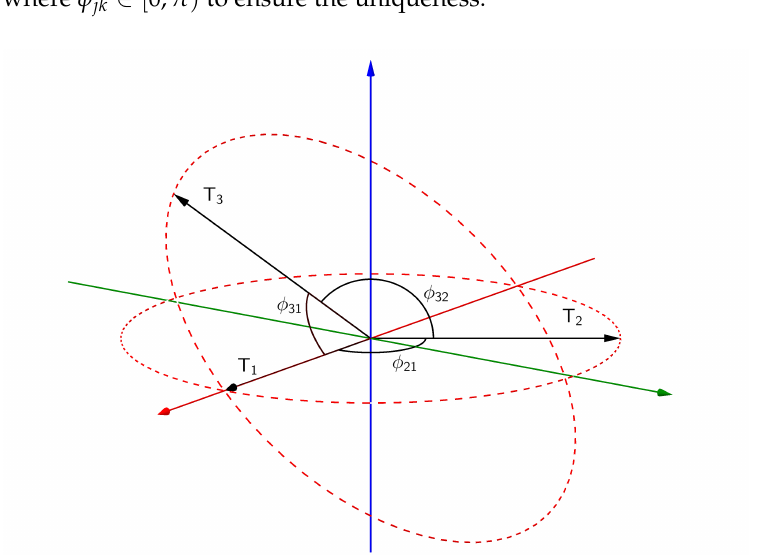
Figure 2. A geometric representation of AHPC when p = 3. The φ jk s are angles between (cid:126) T ( j ) and (cid:126) T ( k ) ,